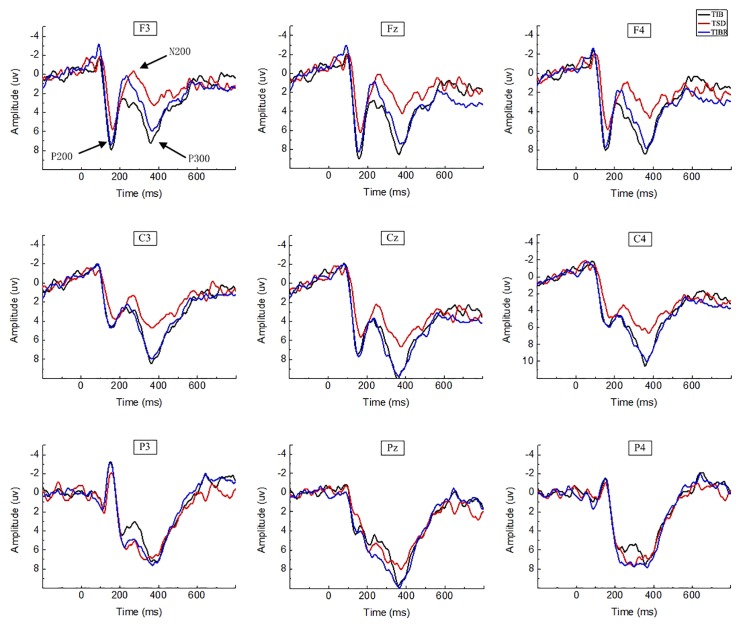
ERP amplitude between sleep conditions for Matching stimuli of working memory. Grand-average ERP (P200, N200, and P300) in the Matching stimuli condition across multiple electrode sites after 8 h time in bed (TIB), after 36 h of total sleep deprivation (TSD), and after 8 h time in bed for recovery (TIBR). The channels are ordered left-right and top-bottom as follows: F3, Fz, F4, C3, Cz, C4, P3, Pz, and P4.